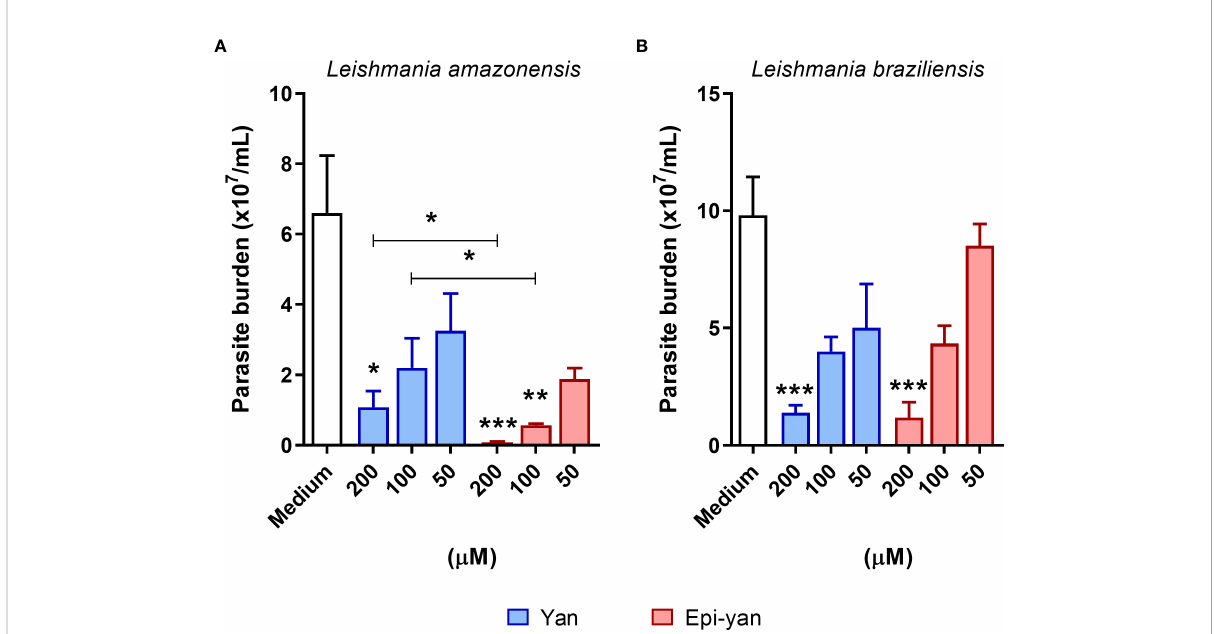
FIGURE 3 Leishmanicidal effect of yangambin and epi-yangambin on the intracellular viability of L. amazonensis and L. braziliensis . BMDM were infected with L. amazonensis or L. braziliensis and treated at varying concentrations of yangambin and epi-yangambin compounds (200 - 50 µM) for 48h. The counting of viable (A) L. amazonensis and (B) L. braziliensis promastigotes recovered from culture supernatants was performed six days after changing culture medium, as described in Materials and Methods . Bars represent ± SD one representative experiment from four independent experiments performed in quintuplicate. The Kruskal-Wallis test, followed by Dunn ’ s post-test, was used for multiple comparisons (*p<0.05, **p<0.01 and ***p<0.0001). La, Leishmania amazonensis ; Lb, Leishmania braziliensis ; Yan, yangambin; Epi-yan: